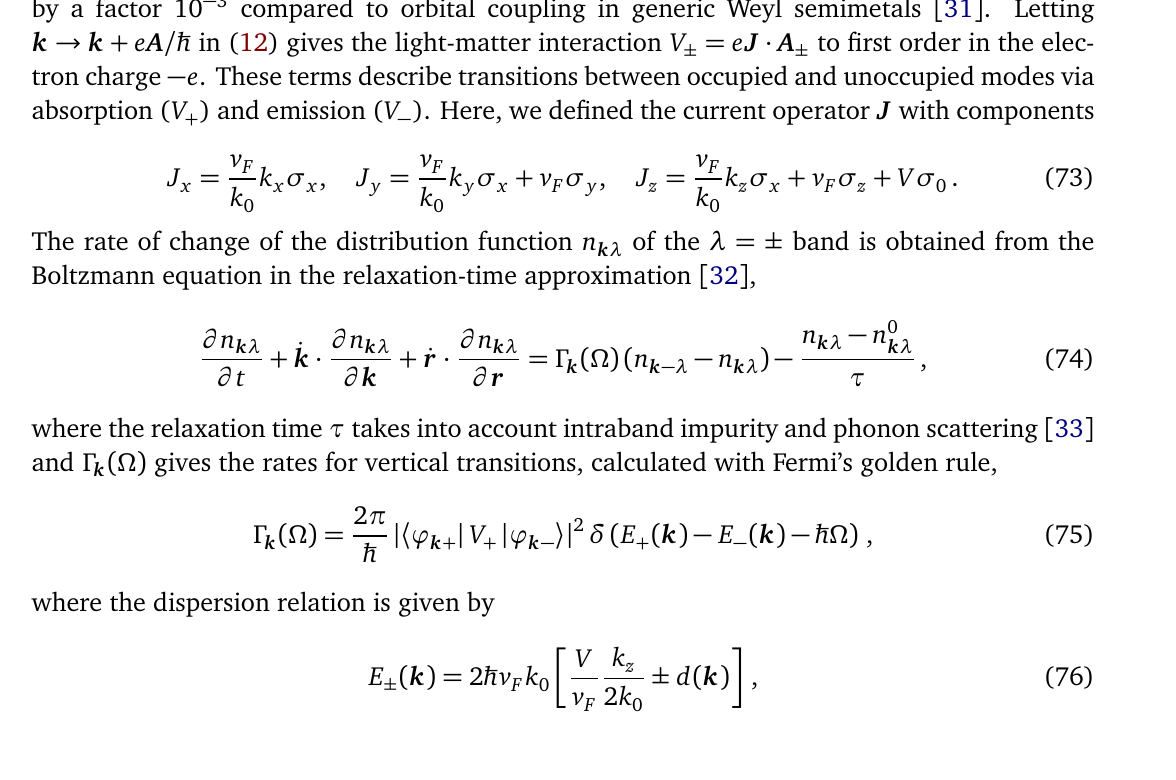
Figure 5: Out-of-equilibrium occupation n the photon energies, in units of 4 πτ ( ev (right). The black region for negative (positive) k where optical transitions are forbidden for E k away from the electron pockets have negative group velocities and are transmitted z across the